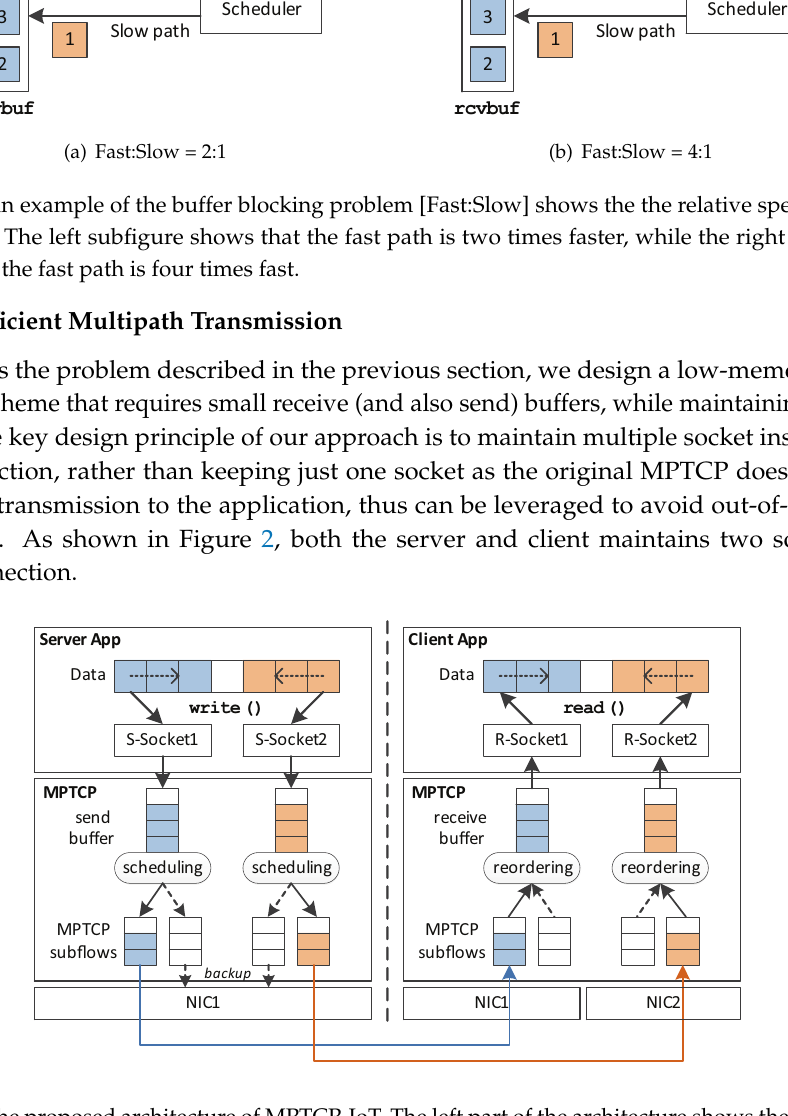
Figure 2. The proposed architecture of MPTCP-IoT. The left part of the architecture shows the operation of the MPTCP-IoT Server, while the right part shows that of the MPTCP-IoT Client. Each application creates multiple socket instances for multipath transmission, and only the main path of each socket is utilized for transmission (reception) at the Server